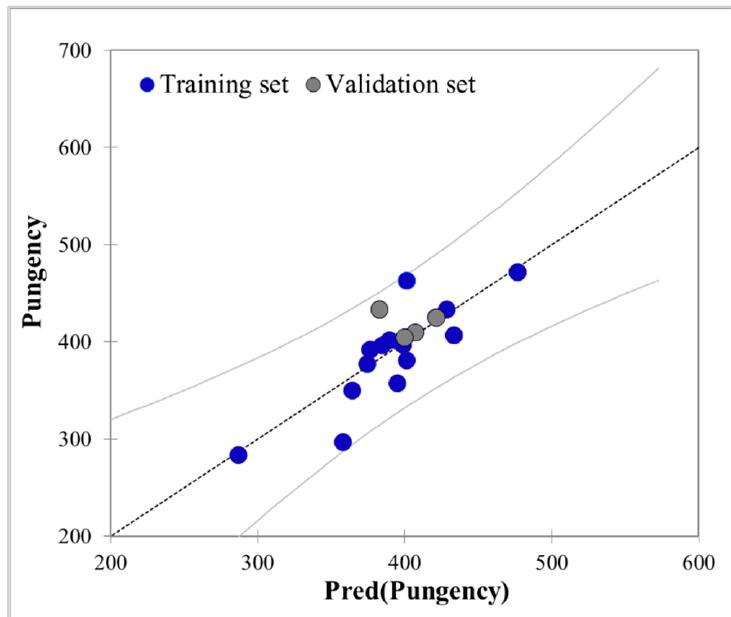
Figure 4. Comparison between predicted and observed values of the pungency calculated by the multiple linear regression